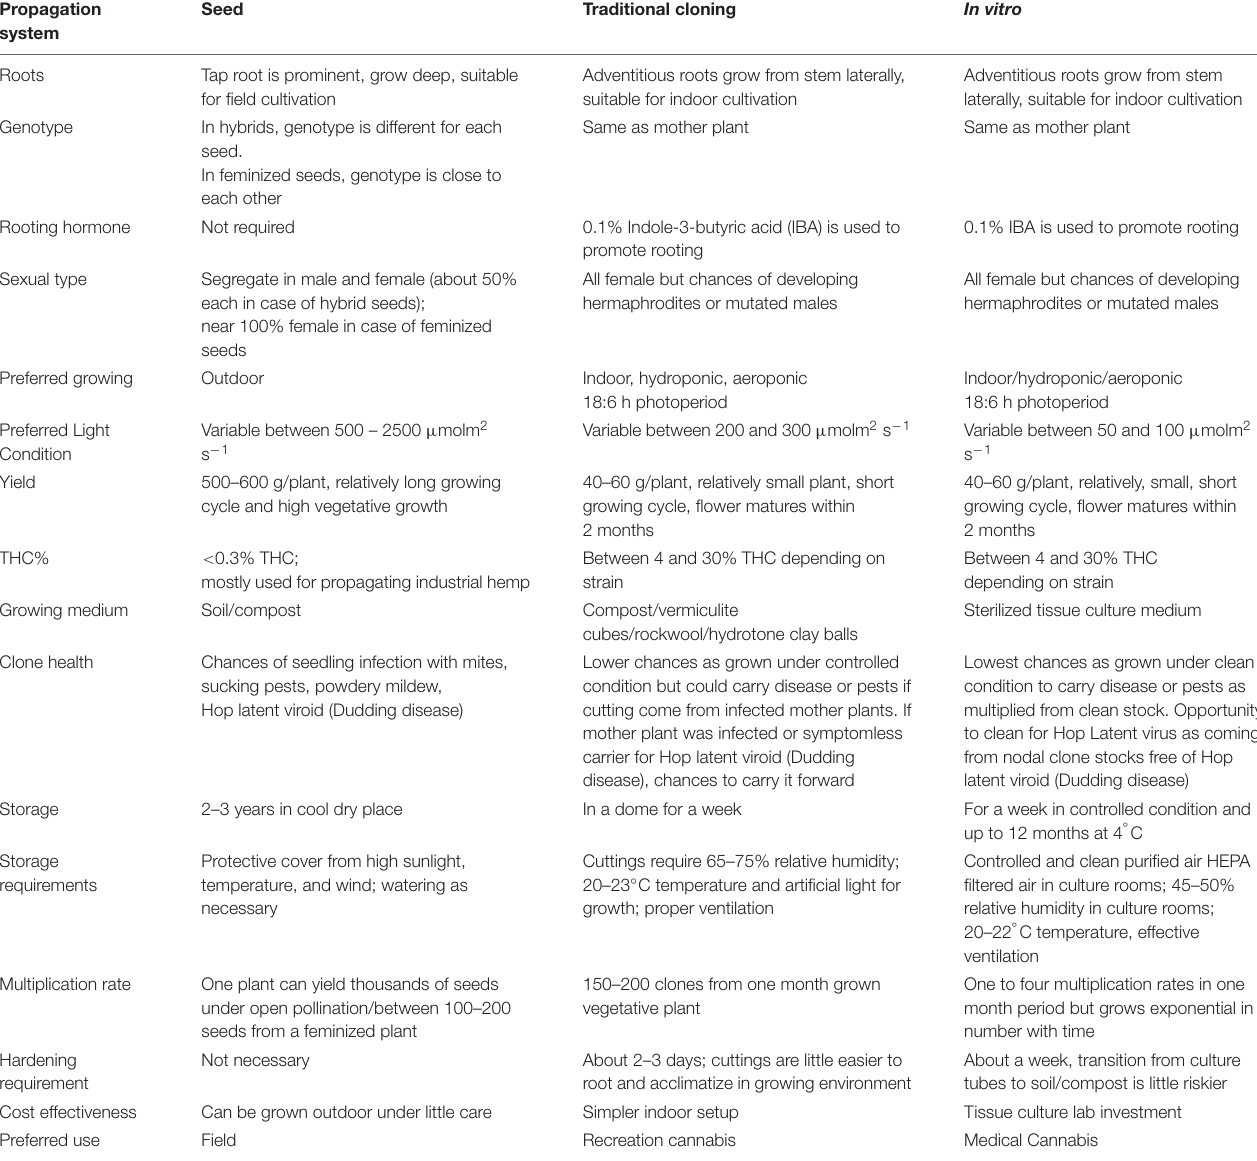
TABLE 2 | Comparison between tissue culture cloning, manual cloning, and seed propagation in cannabis. Propagation system